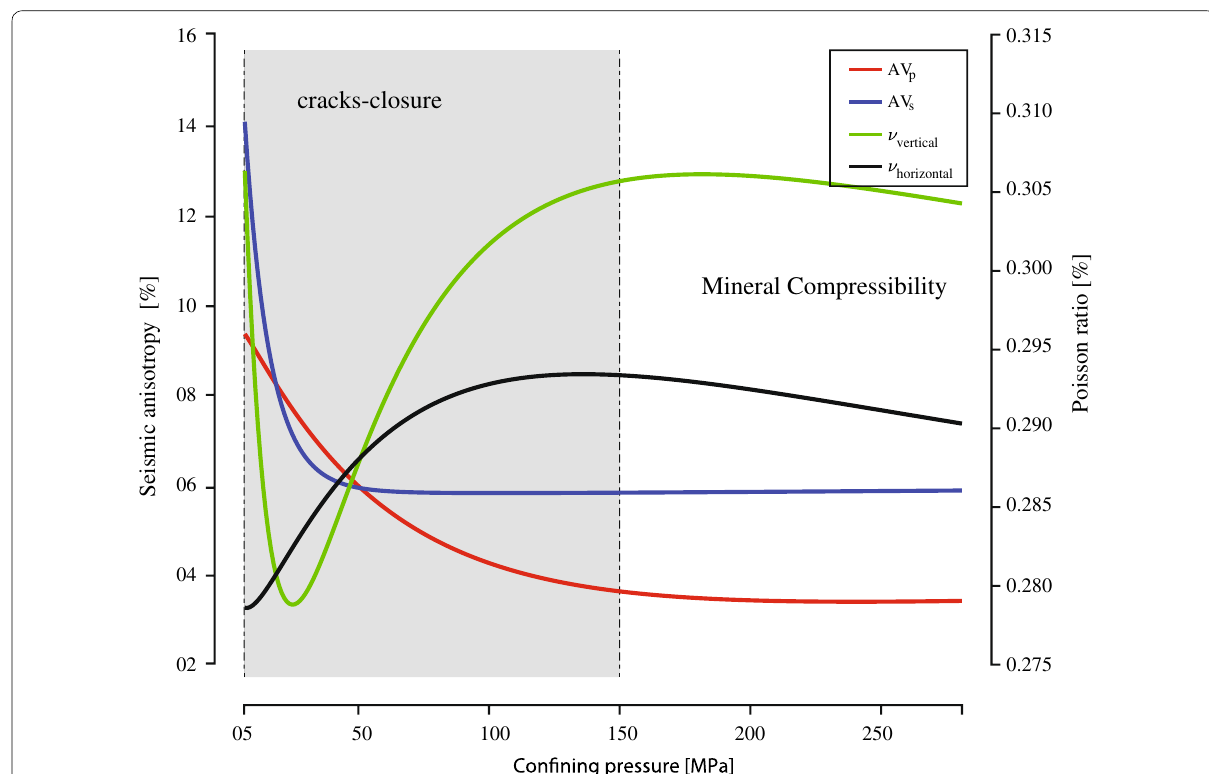
Fig. 9 Example of seismic velocity anisotropy and Poisson’s ratio as a function of confining pressure up to 300 MPa. The curves are inter- and extrapolated from laboratory measurements using the equation of Wepfer and Christensen (1991). The plot is split into two areas, on the basis of the linearity of the curves. The low-pressure zone, where the curves are non-linear, represents the pressure interval where the seismic behavior is dominating by crack and pore closures (e.g., Birch 1960). It shows an abrupt decrease due to the closure of the aligned microcracks which reinforce the anisotropy induced by the lattice-preferred orientation (LPO) of anisotropic minerals (sample: HU24). Above 150 MPa, the curves become linear; the elastic behavior of the rocks is determined by the elastic moduli of the rock-forming